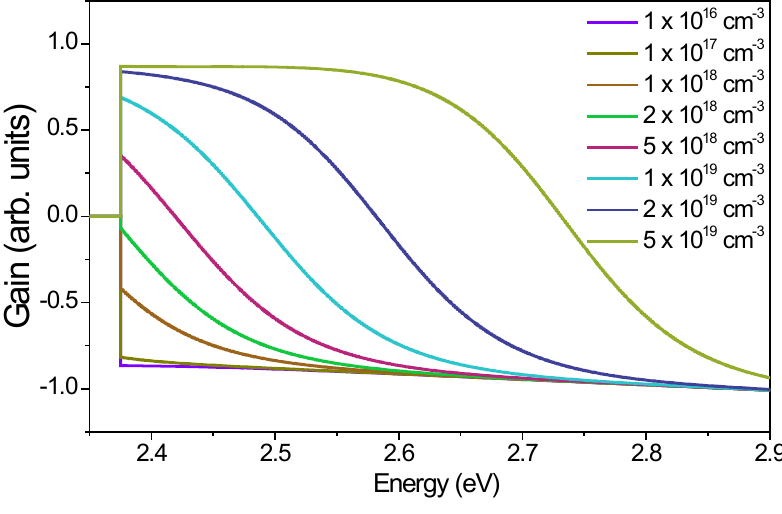
Figure 6. Gain vs. energy curves retrieved for different carrier densities.